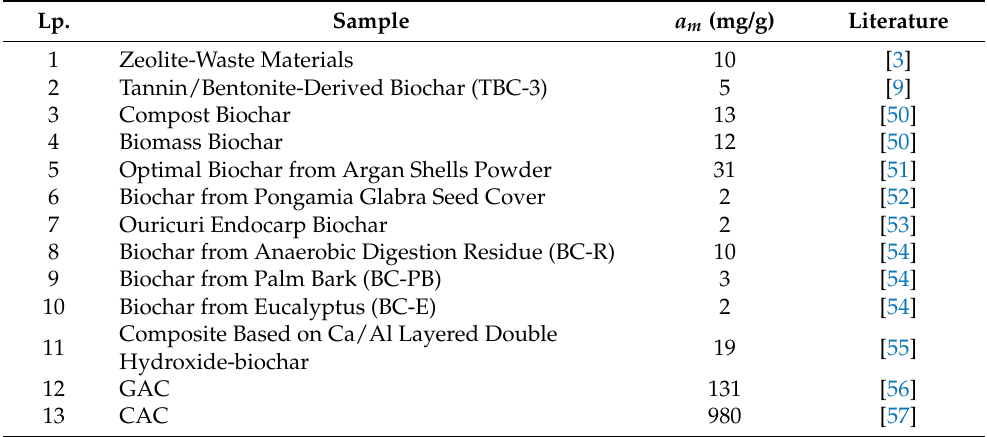
Table 6. Comparison of literature data regarding methylene blue adsorption on biochars and com- mercial activated carbons.